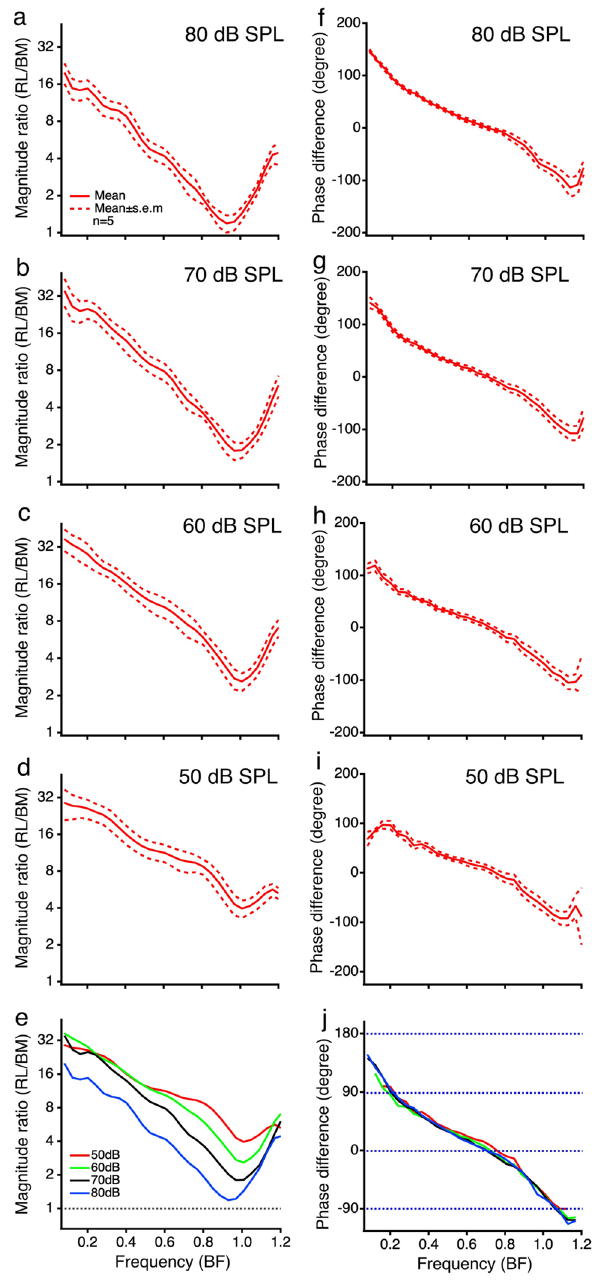
Figure 3. The magnitude and phase differences between the reticular lamina and basilar membrane vibration in five sensitive cochleae. ( a – d ), Means and standard errors of the magnitude difference between the RL and BM vibration presented by the ratios of the RL displacement to the BM displacement as a function of frequency at 80, 70, 60, and 50 dB SPL. Displacement ratios are the largest at low frequencies below 0.2 BF and decrease and then increase with the frequency reaching a minimum at the BF. All magnitude ratios are larger than one, indicating that the RL vibrates more than the BM. ( f – i ), Means and standard errors of the phase difference between the RL and BM vibration as a function of frequency at different sound pressure levels. The phase difference decreases with frequency at a similar rate at all sound pressure levels. ( e ), Means of the magnitude differences between the RL and BM vibrations at different sound levels. The magnitude difference curves shift downward as the sound pressure increases, suggesting the strongest nonlinear compression near BF. ( j ), Means of the phase differences between the RL and BM vibration at different sound pressure levels. Overlapping phase difference curves indicate that the group delay difference between the RL and BM vibrations does not change with the sound pressure